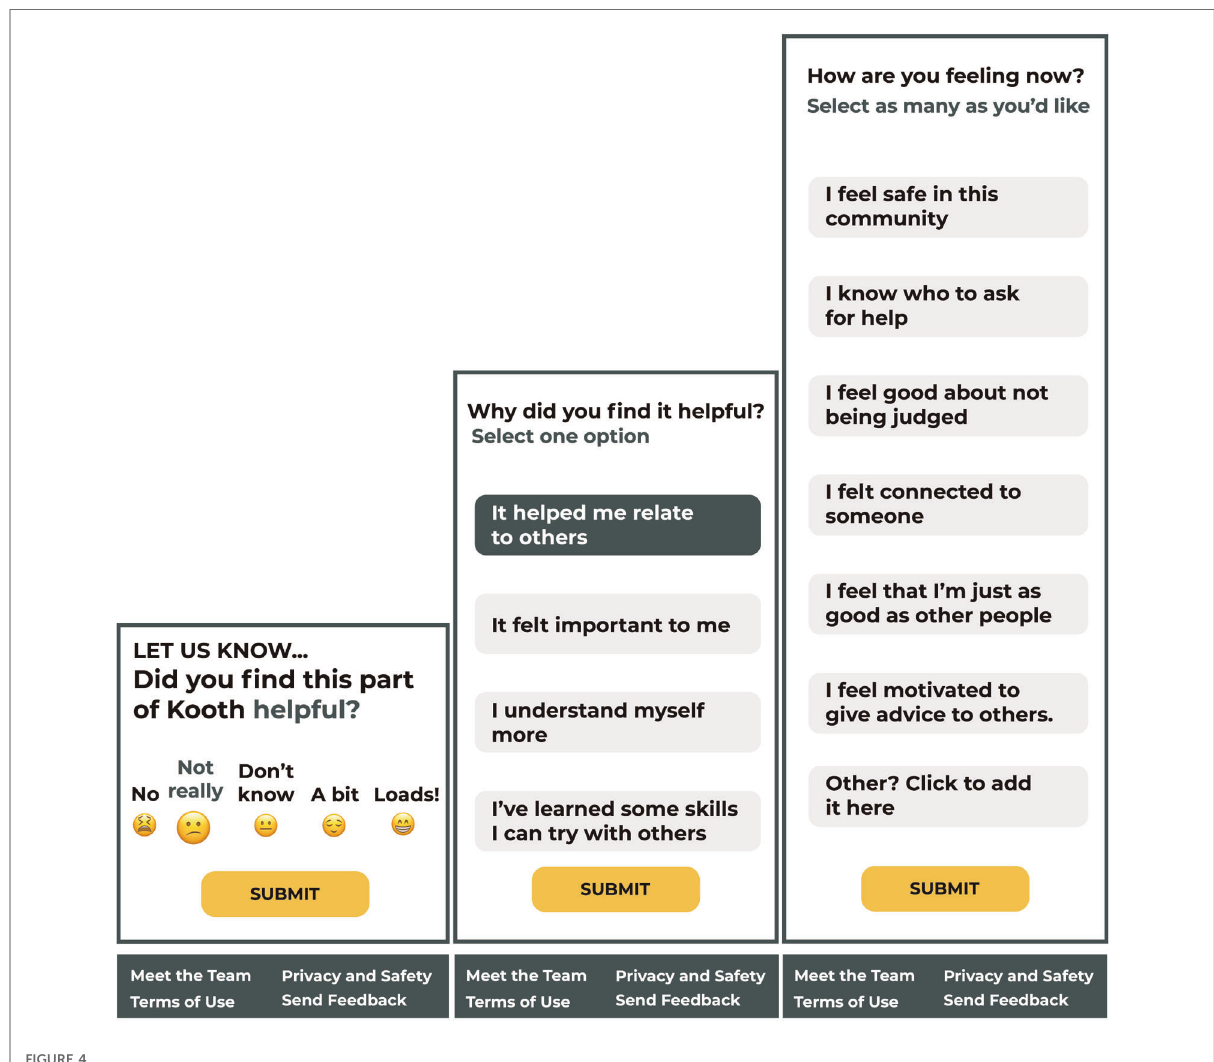
FIGURE 4 High- fi delity clickable prototype of the three stages for